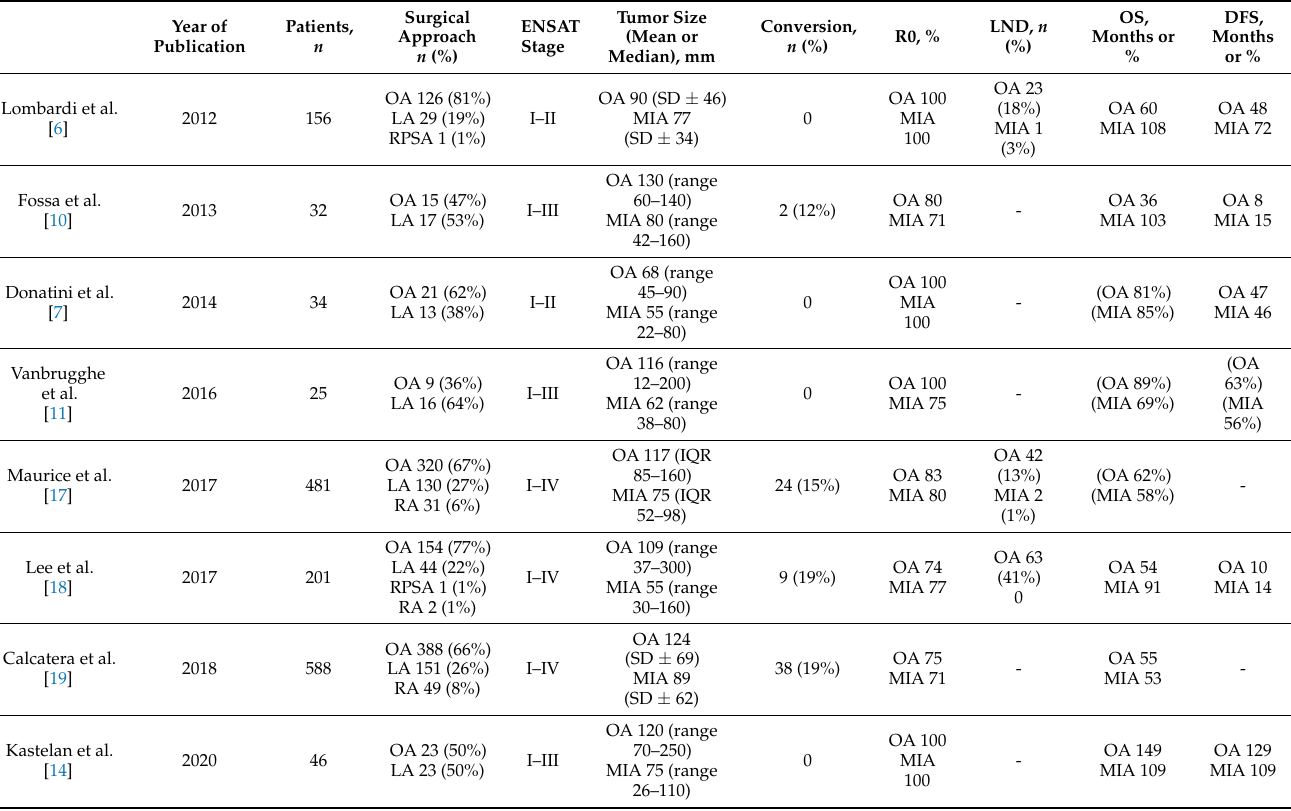
Table 2. Studies supporting minimally invasive approach for the treatment of